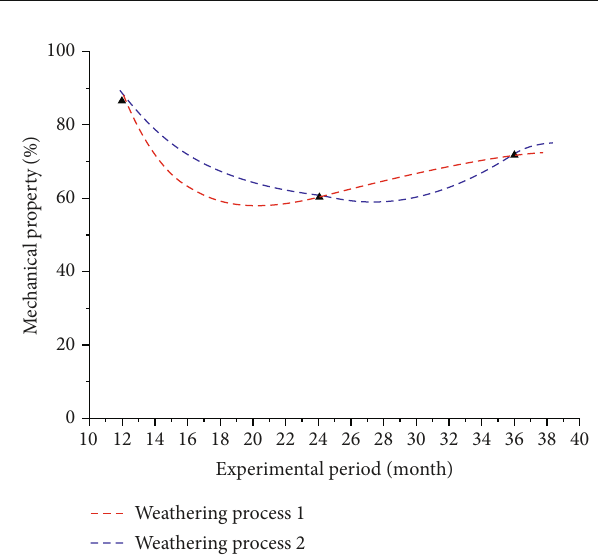
Table 11: Classi fi cation accuracy of various experimental periods in incomplete data areas.